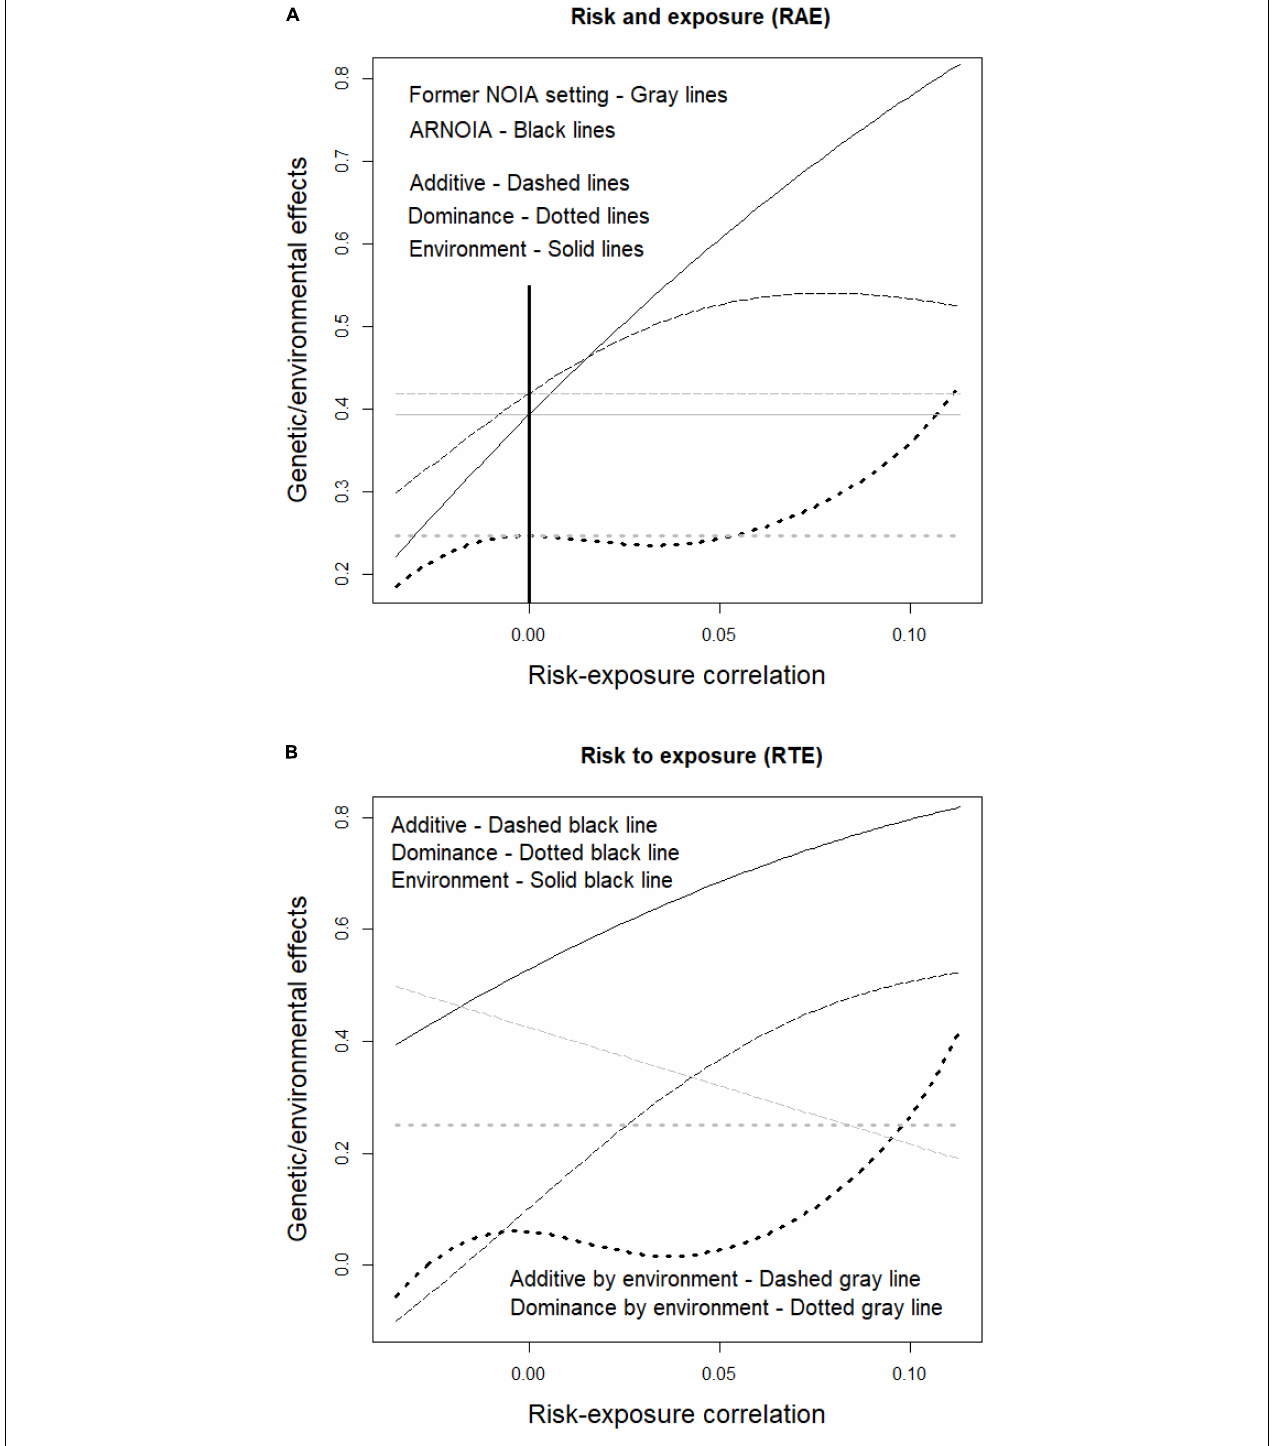
FIGURE 1 | Genetic and environmental effects of disease susceptibility influenced by a risk allele and environmental exposure, for the whole range of possible correlations (including negative and positive associations) of the risk allele and environmental exposure. The risk allele frequency is 0.15, with genotypic frequencies under Hardy–Weinberg equilibrium, and the environmental exposure frequency is 0.24. The RAE case (see Table 1 ) is shown in panel (A) , where the former NOIA setting and ARNOIA, shown with gray and black lines, respectively, are compared. The thick black solid vertical line marks the case of random association (i.e., no correlation) between risk and exposure. The genetic effects obtained with ARNOIA for the RTE case (see Table 1 ) are shown in panel (B) . The marginal genetic and environmental effects are shown with the same black lines as in panel (A) and gray lines are used here for the interaction effects.